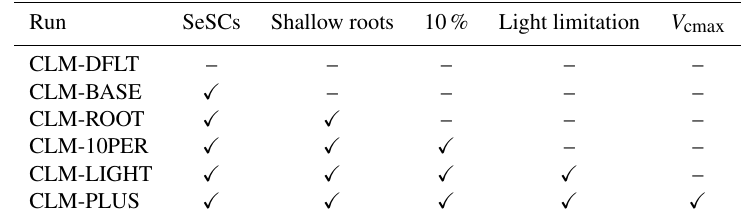
Table A4. Overview of the different modifications of CLM4.5 incorporated in the simulations presented this study.